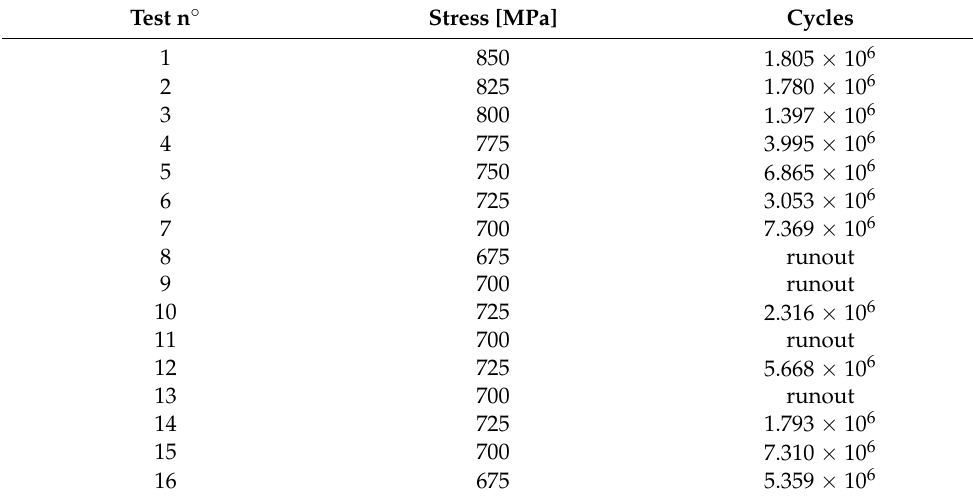
Figure 7. Complete staircase results of nitrided specimens. Table 8. Stress and cycles by each test of the staircase of the nitrided specimens.